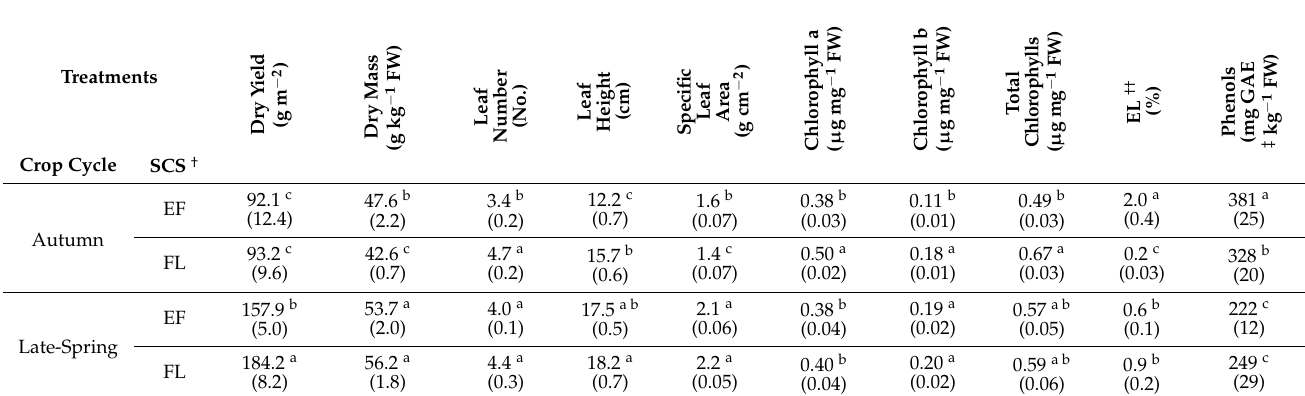
† SCS, soilless cultivation system: EF = ebb and flow system; FL = floating system. †† Electrolyte leakage. ‡ GAE: gallic acid equivalent. a–c Means ( n = 6) in columns not sharing the same letters are significantly different according to the LSD test ( α =